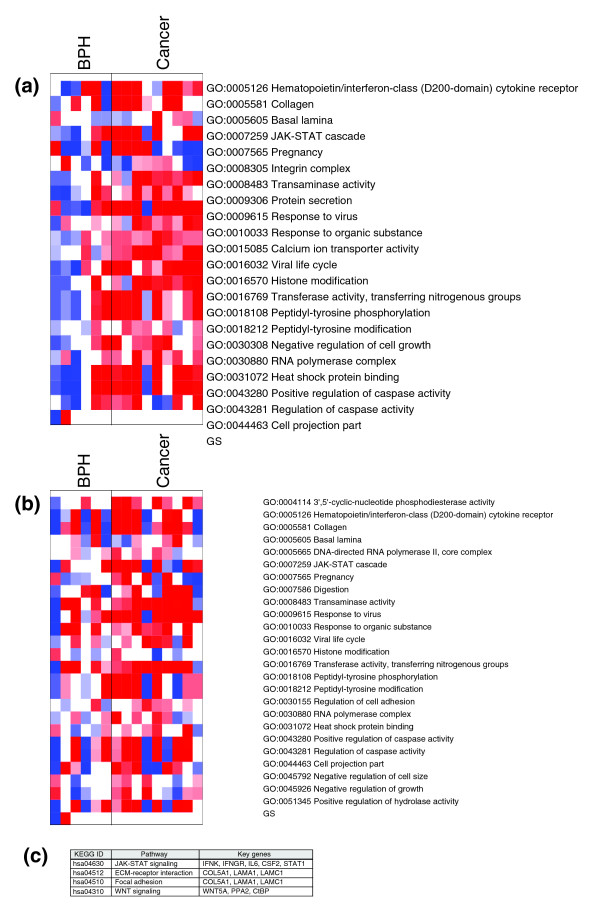
Functional annotation of the cancer stem cell expression signature. (a,b) Functional concepts over-represented in cancer relative to BPH within the stem cell population (a) or within the committed basal population (b) derived from the GO. Over-represented terms are shown in red, and under-represented terms are shown in blue. (c) Examples of key pathways and related genes involved in over represented gene ontology functions.